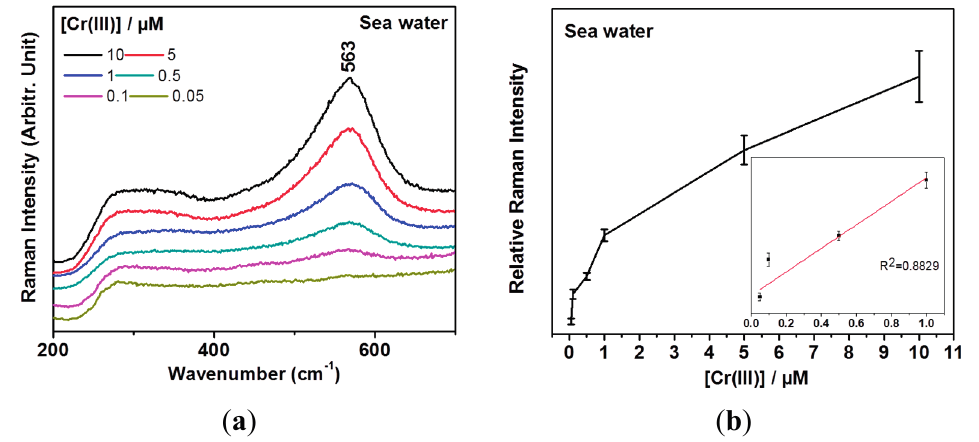
Figure 5. ( a ) Test of real seawater sample for the Cr(III) detection; ( b ) A calibration curve of the vibrational band intensities. Three independent measurements were performed to yield the standard deviations as marked in the error bars. The inset shows a linear fitting result for the 0.05 and 1.0 μ M regions.